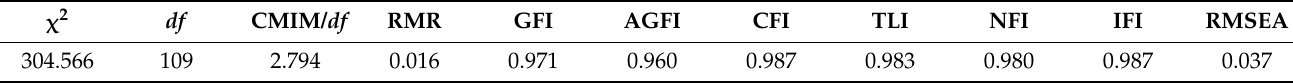
Table 5. Validity analysis result through confirmatory factor